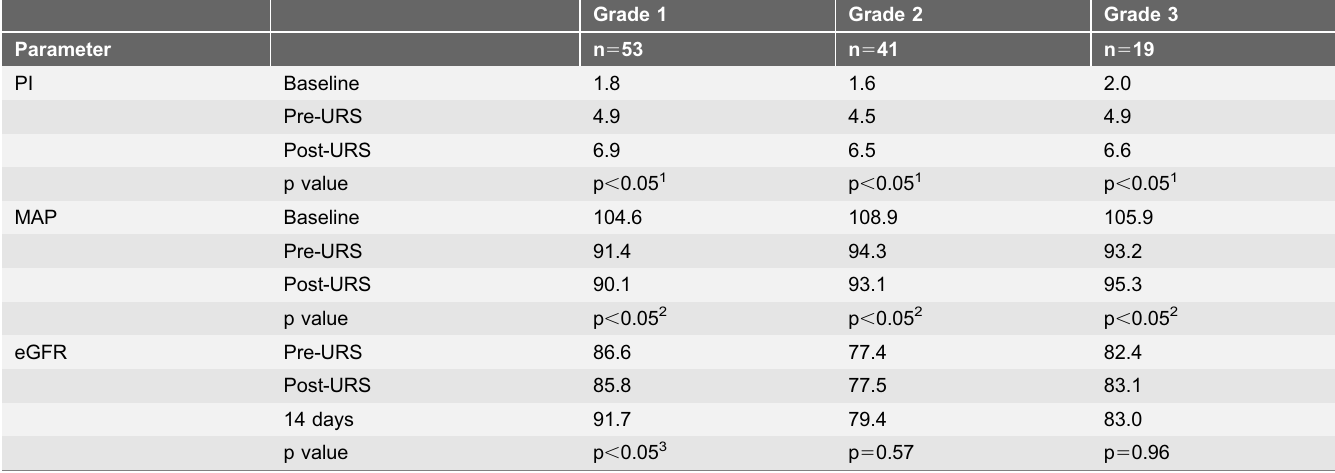
Table 2. The changes in PI, MAP, and eGFR in the 3 hydronephrosis groups. (compared with repeat measurement ANOVA and then Turkey HSD test each other).